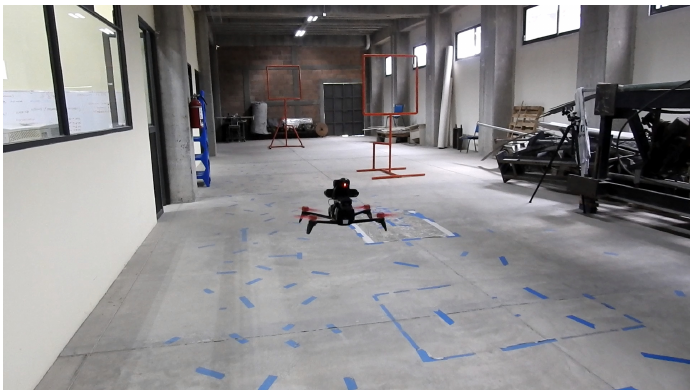
Figure 11. Indoor environment for our experiments where the drone had to fly through gates. All processing was performed on board using an OAK-D smart camera and an Intel Stick Compute processor.